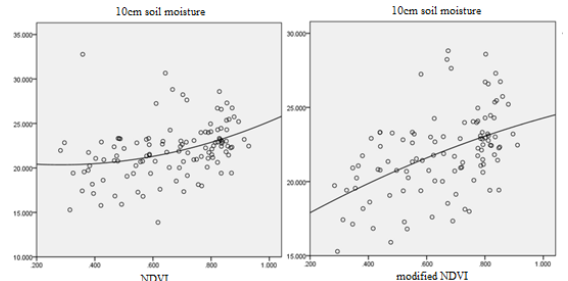
Figure 5. Regression curve of 10cm soil moisture on NDVI and modified NDVI in 4.29 in central Henan